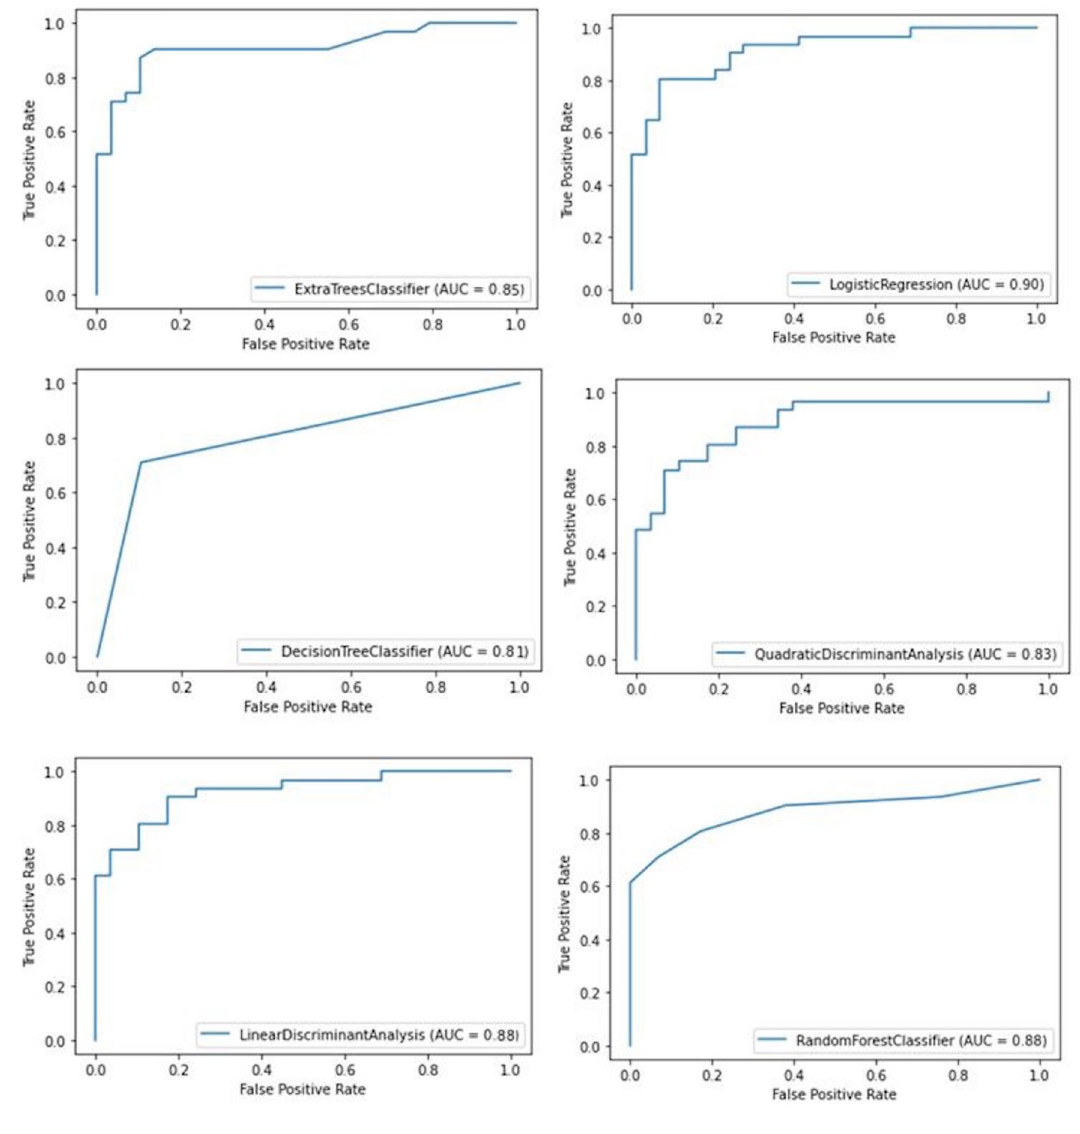
Figure 2. ML ROC